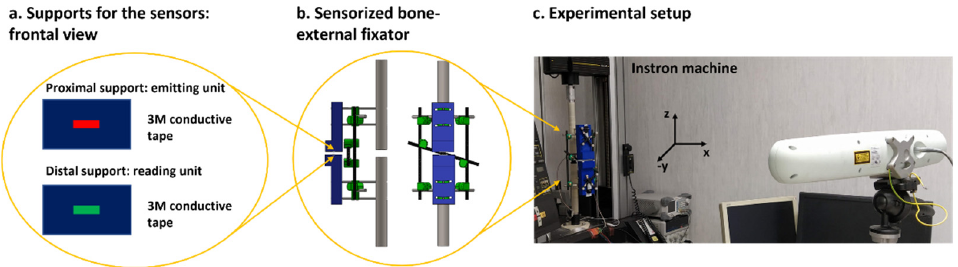
Figure 6. Experimental setup for testing the capacitive sensor technology.